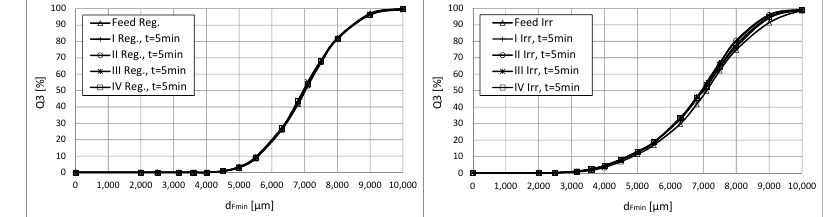
Figure 12. Cumulative particle size distribution functions of chalcedonite feed with regular (Reg) and irregular (Irr) particles.